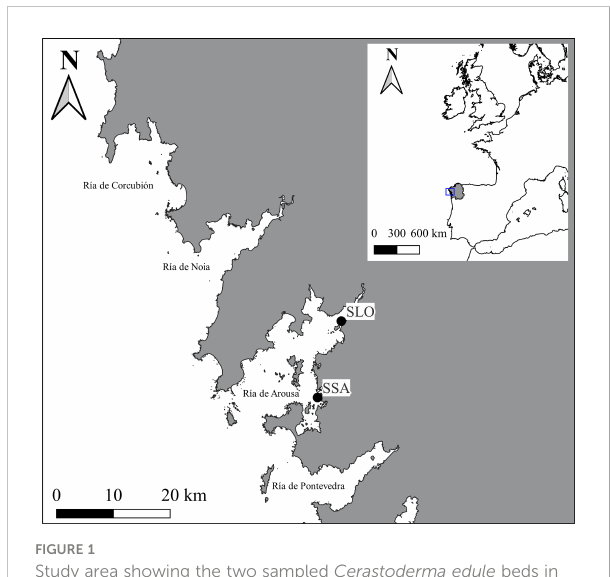
FIGURE 1 Study area showing the two sampled Cerastoderma edule beds in the R ı ́ a de Arousa (Galicia, NW Spain). Geographic Coordinate System – EPSG:25829 − SLO: Lombos do Ulla (518449 - 4719641); SSA: O Sarrido (514263 –